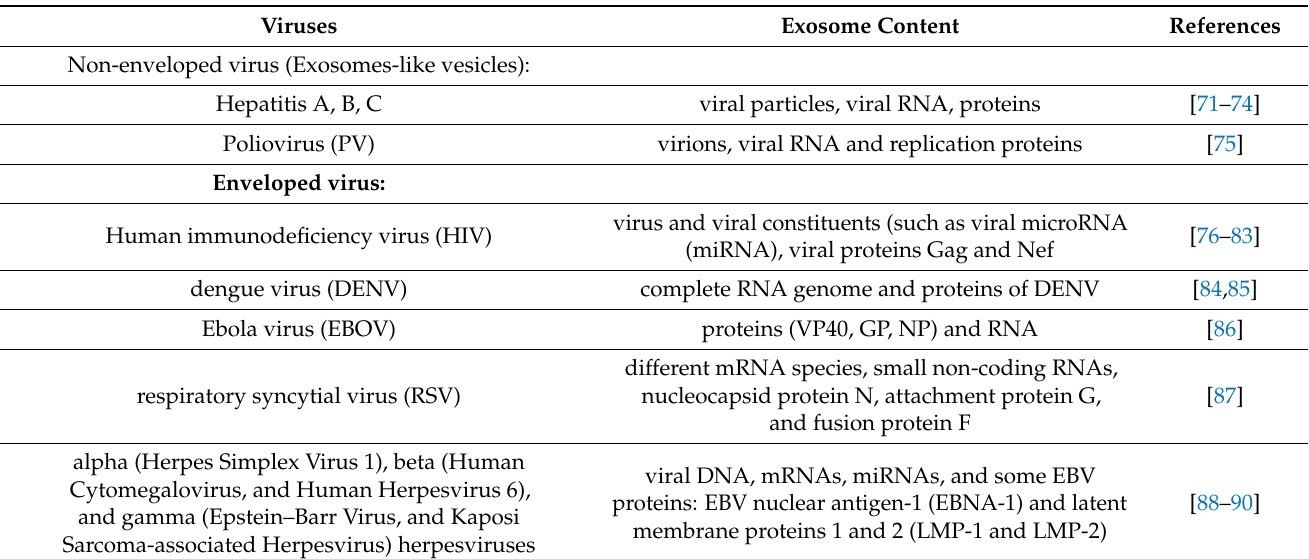
Table 1. Viruses that use exosomes for cell-to-cell